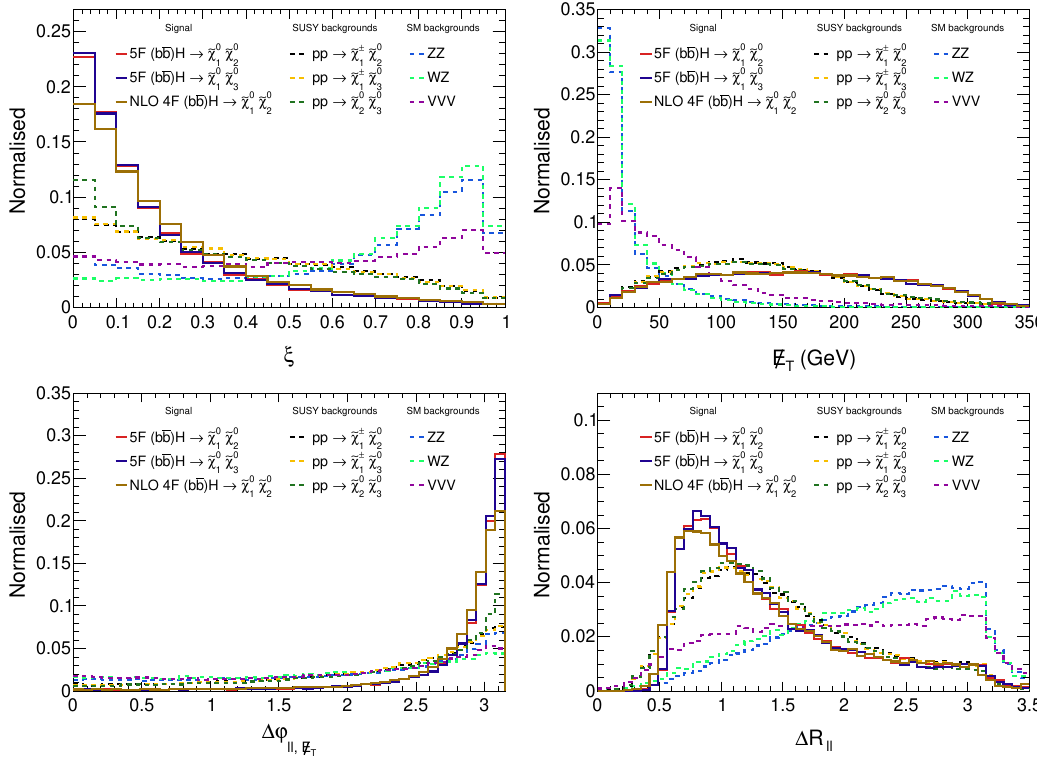
Figure 16. The normalised distributions of ξ , /E for the b-veto category of ‘‘ + /E scenario. We show the signal distributions for 5F b ¯ b → H in b ¯ bH production in in dashed